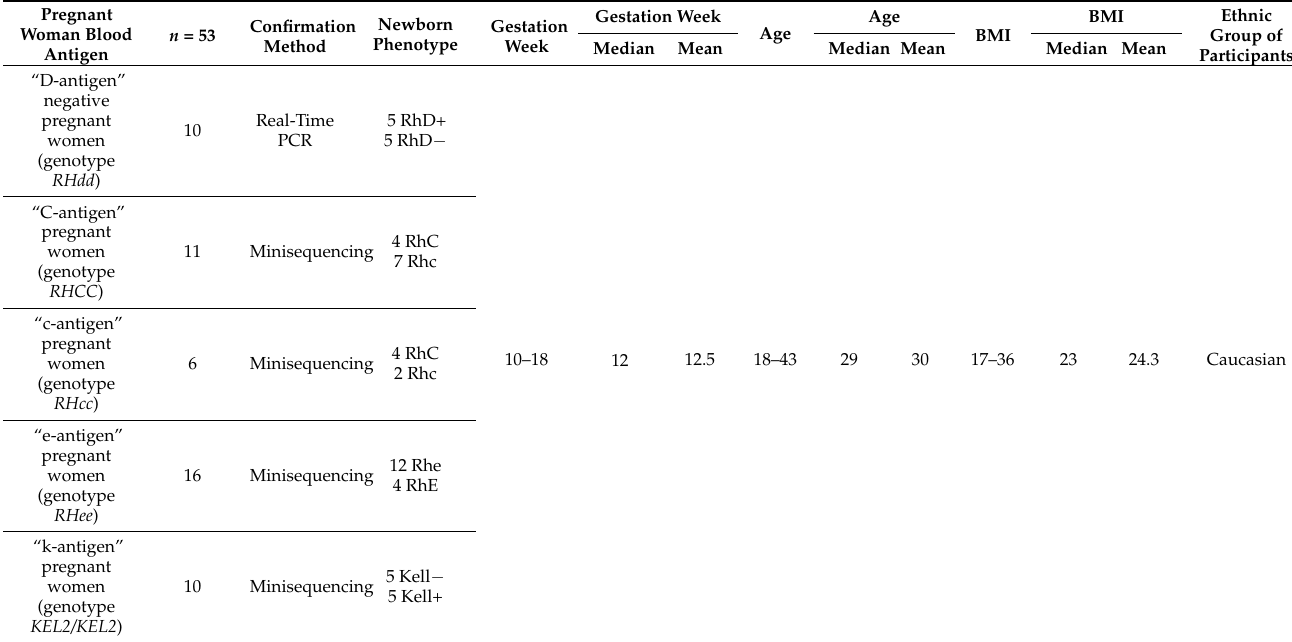
Table 1. Characterization of the sample